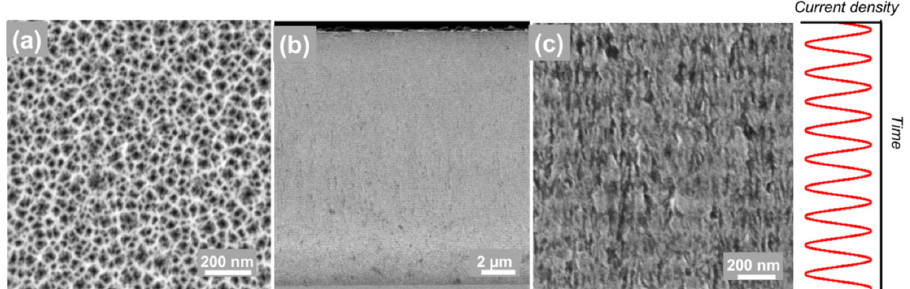
Figure 1. FESEM images of pSiRF sensor: ( a ) Top view; ( b , c ) cross ‐ sectional views with low and high magnification, respectively, showing the modulated pore diameters. The schematic temporal current density profile corresponds to the data in panel ( c ).